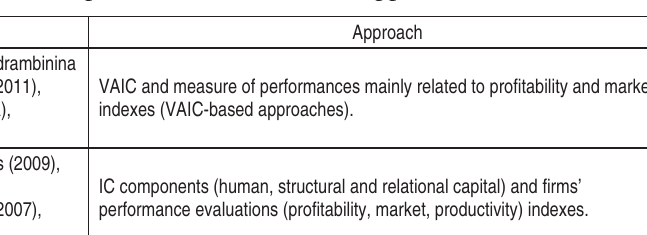
Table 1. Summary of IC and firms’ performances evaluation